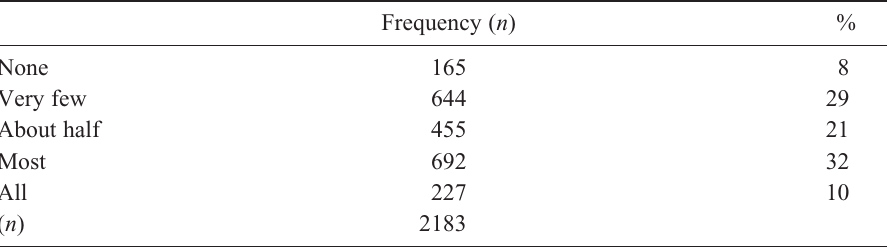
Table 3. Number of courses which use